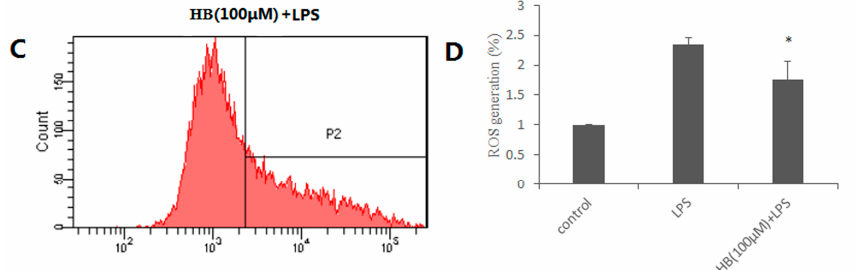
Figure 5. Effects of HB on LPS-induced ROS production in RAW 264.7 Cells measured by flow cytometry. ( A ) Control ( B ) LPS (1 μ g/mL) ( C ) RAW 264.7 Cells were pretreated with 100 μ M HB for